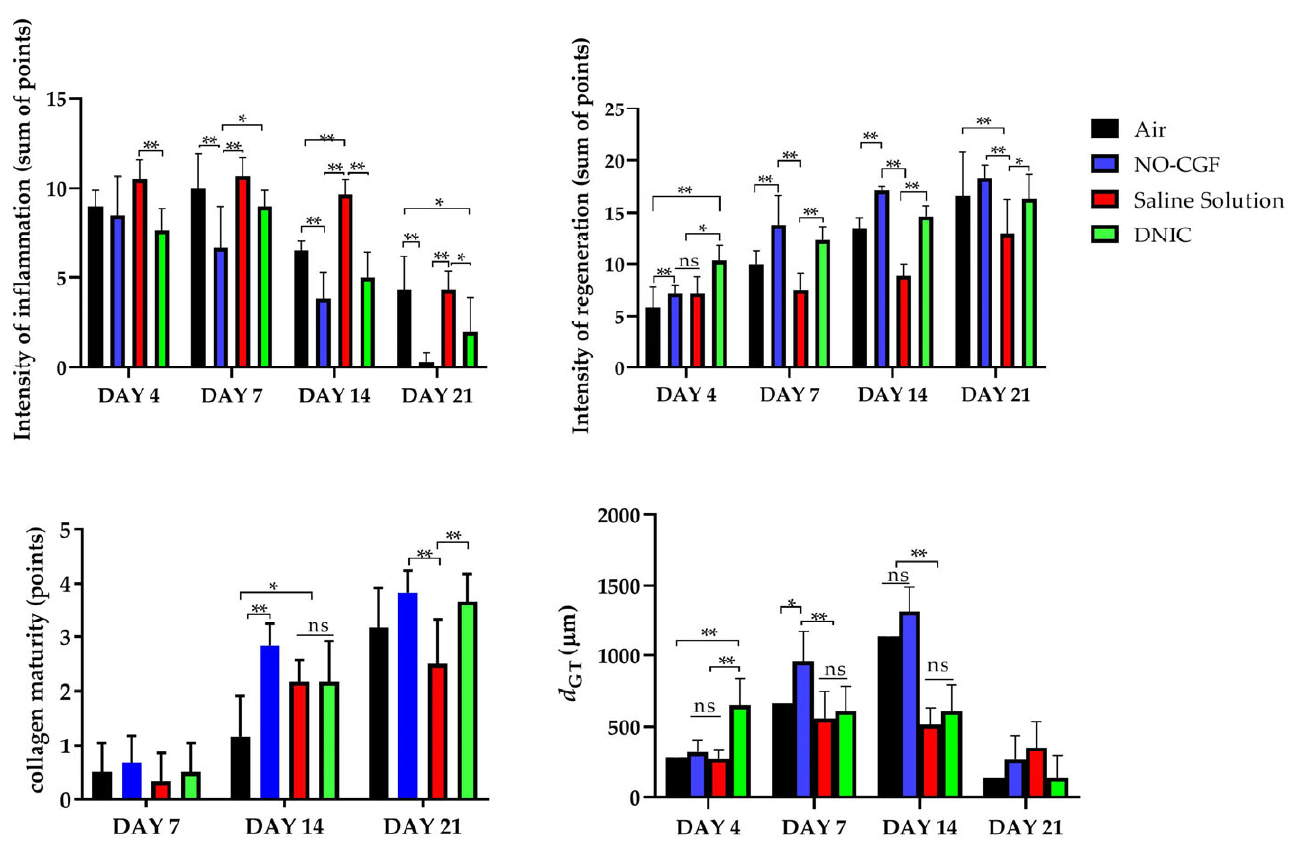
Figure 8. Morphometry of the wound tissues, two-way ANOVA tests, median and 95% CI. dGT— granulation tissue thickness, ns—non-significant, *— p < 0.05; **— p < 0.01.